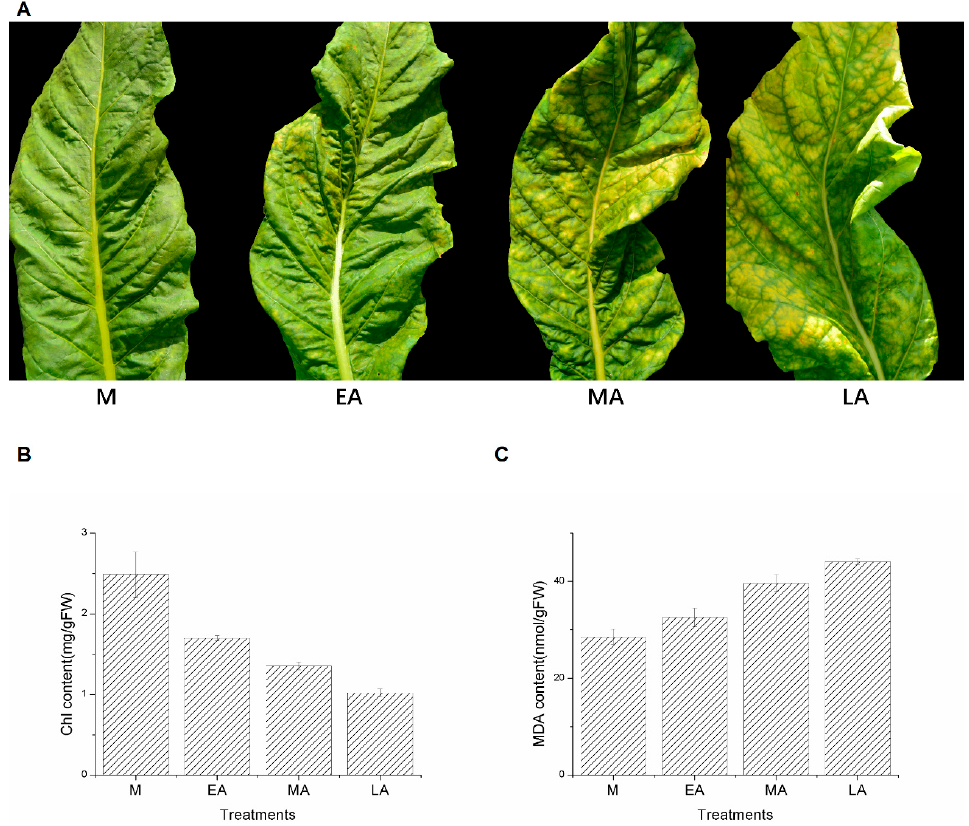
Figure 1. Plant phenotypes, Chlorophyll (chl) and malonaldehyde (MDA) measurements at the four stages of premature senescence. M, mature, EA early senescence, MA middle senescence, LA late senescence. ( A ) Appearance of tobacco leaves at four stages of premature senescence. ( B ) chl content. ( C ) MDA content. Error bars indicate the means ± SD (n = 3).